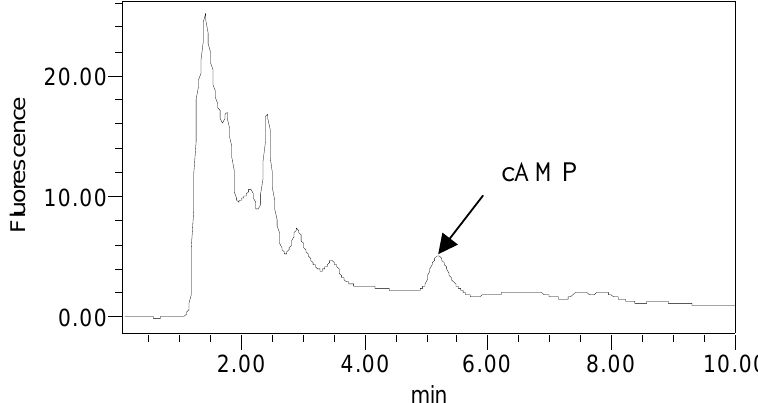
Figure 5. Chromatogram of cAMP determination in the CNS of locust using TBAS buffer with HPLC-FL.